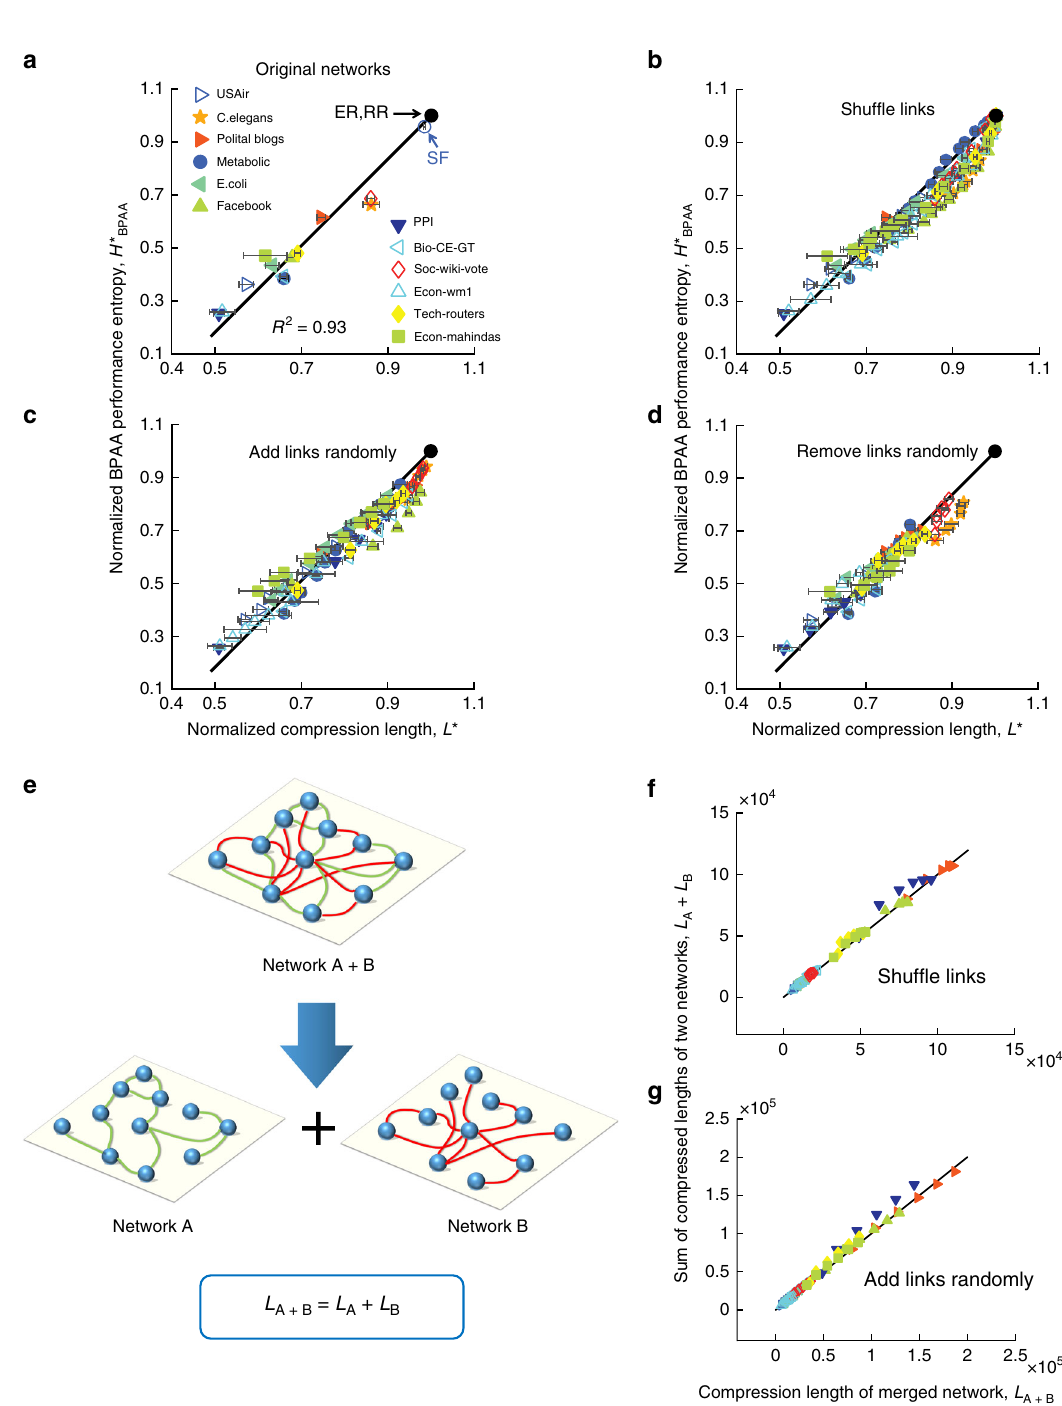
Fig. 2 Network prediction limit vs. shortest compression length on empirical networks. a For empirical networks drawn from different fi elds, the values ð L (cid:2) ; H (cid:2) Þ fall on the linear relationship in the black straight line given by Eq. (3). The horizontal error bars indicate the standard derivation of the BPAA compression length across 50 calculations (see Supplementary Note 2). The standard deviation of the slope is 0.06 obtained by the bootstrap method 34 and the coef fi cient of determination R 2 is 0.93. b Similar plot to ( a ), with each empirical network having its links shuf fl ed different number of times up to all of original links. After shuf fl ing, the values ð L (cid:2) ; H (cid:2) Þ move towards the point of ER network but still fall on the same linear straight line as in a . c Random BPAA addition of links up to the same number of links of the original network and ( d ) random removal of links up to half of original number of links in the various empirical networks. The resulting compression length L * and predictability H (cid:2) still have the same linear relationship as the original networks in a BPAA A. e A schematic representation of combing two networks with the same nodes into one. f Values of L A + B vs. L A + L B in the case of shuf fl ing links in empirical networks. A network after shuf fl ing operation can be viewed as consisting of two independent subnetworks A and B : A refers to a network which only contains the shuf fl ed links, i.e., an exact ER network; and the B is the remaining network with original links in the empirical network. g Similar plot to ( f ) in the case of randomly adding links in empirical networks. Here network A is an ER network containing all of the randomly added links while network B refers to the original real